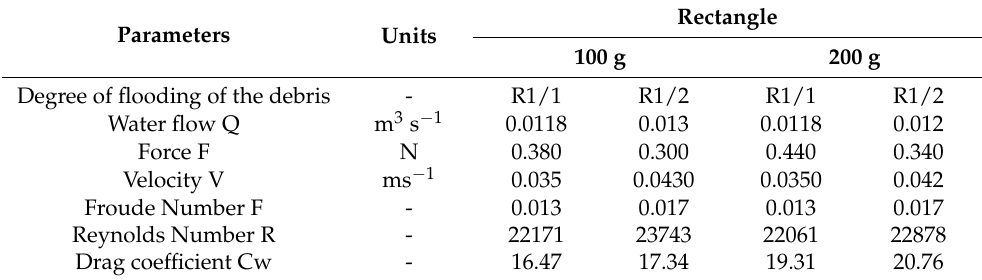
Table 1. Hydraulic parameters of water